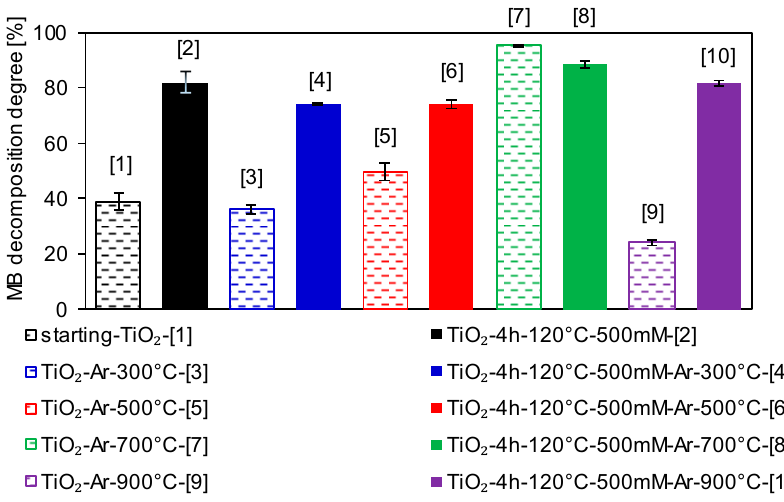
Figure 9. Methylene blue decomposition degree after 240 min of UV light irradiation for starting TiO 2 , calcined reference samples, and APTES-modified TiO 2 prior to and after process.